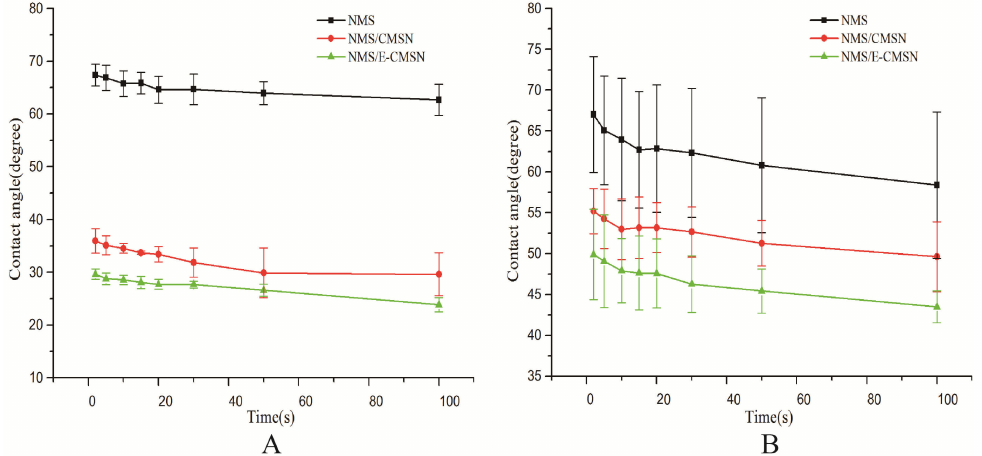
Figure 6. Contact angle measurement results of NMS, NMS / CMSN, NMS / E-CMSN with ( A ), pH 6.8 PBS; ( B ), pH 6.8 PBS (including